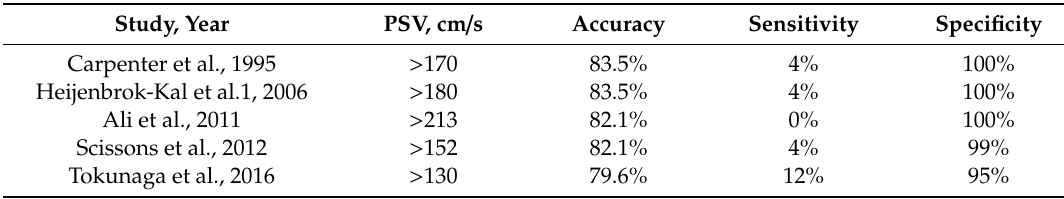
Table 3. Accuracy of traditional methods for carotid stenosis.